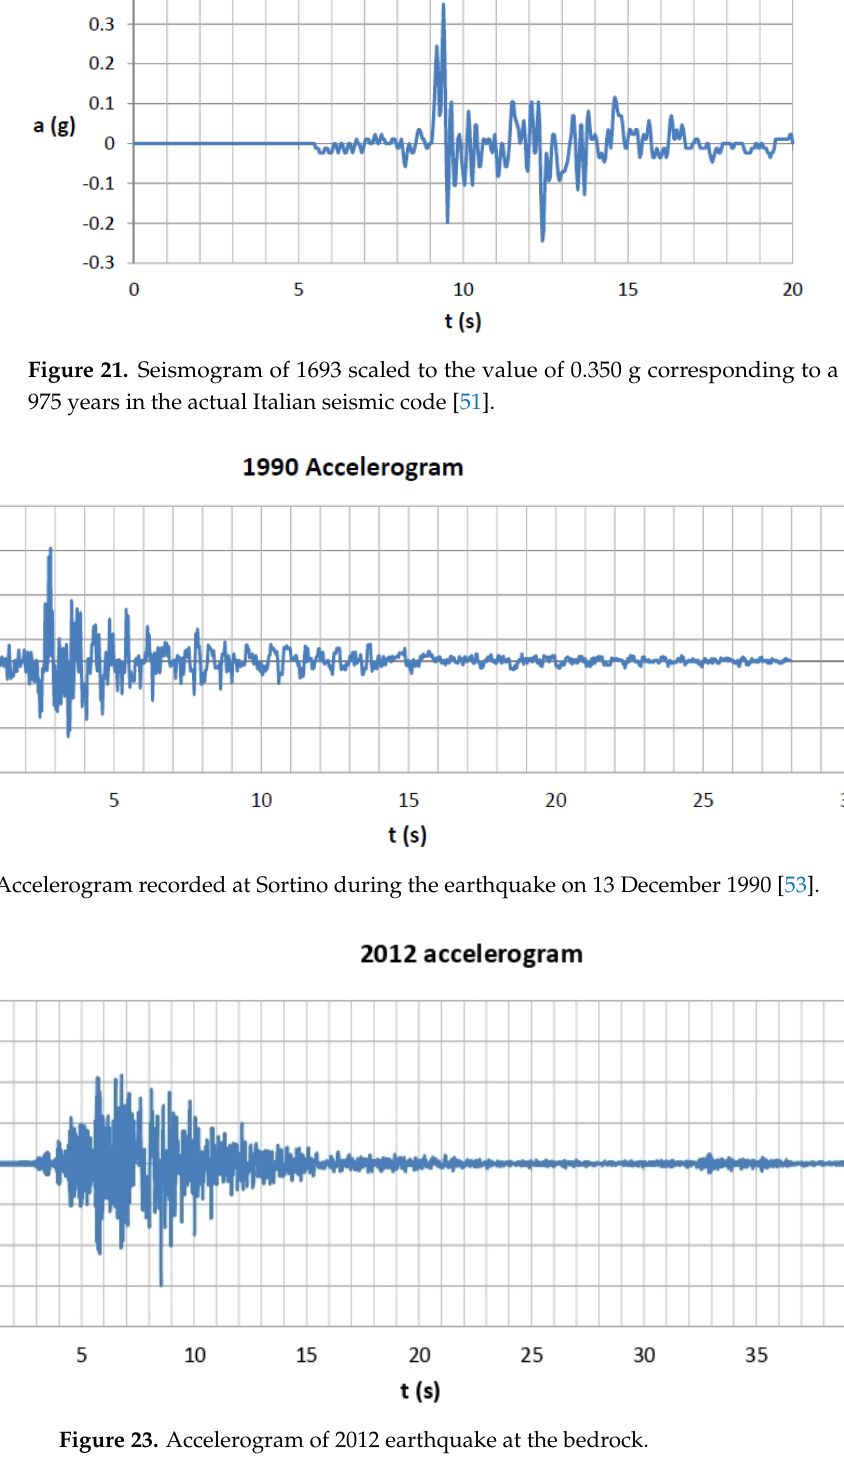
Figure 23. Accelerogram of 2012 earthquake at the bedrock.